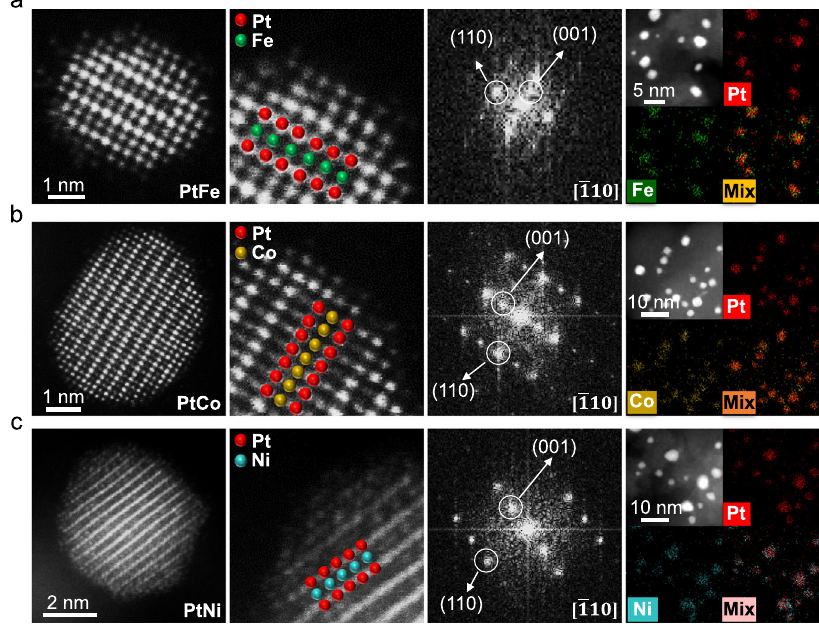
Fig. 4 | Atomic scale HAADF-STEM characterization. Atomic-resolution HAADF- STEM images, fast Fourier transform (FFT) patterns, and energy dispersive